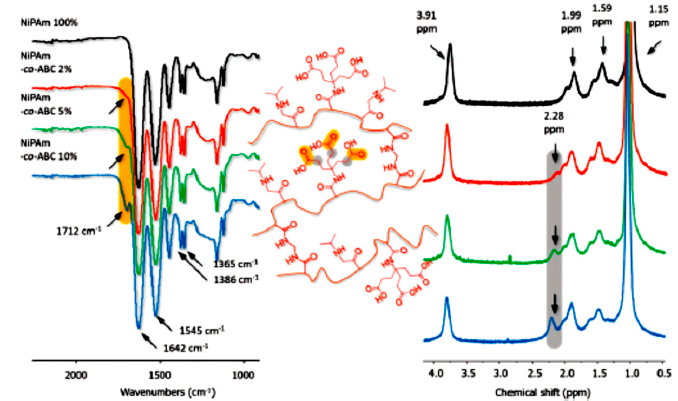
Figure 10. FT-IR (on the left) and 1 H-NMR (on the right) spectra of NiPAm-based nanogel. Reproduced from G.N. Rimondino et al. [25].